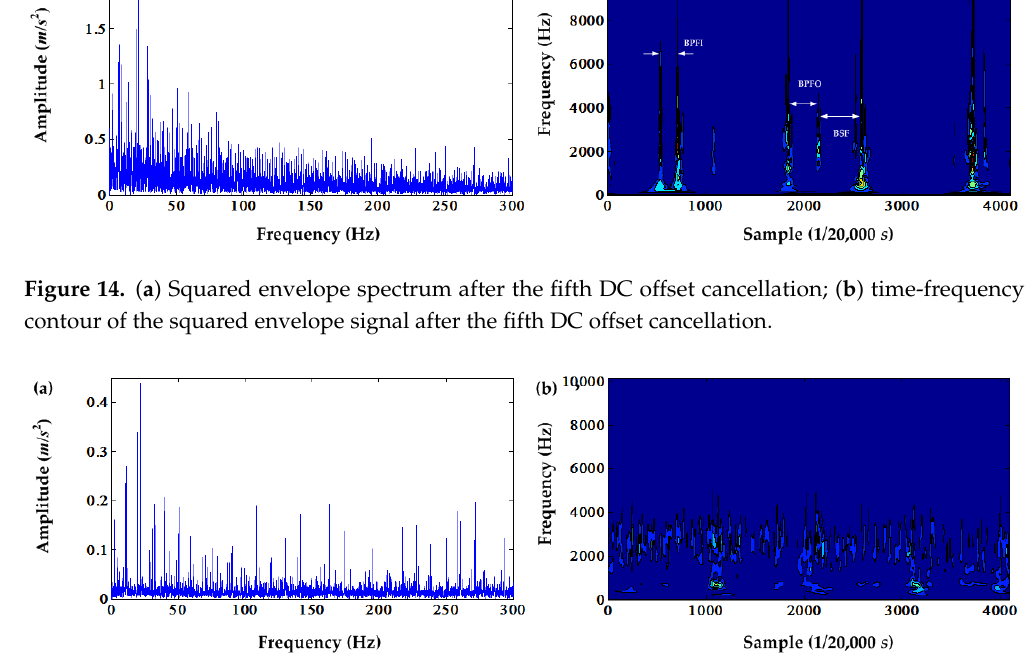
Figure 16. Frequency spectrum of the time synchronous signal